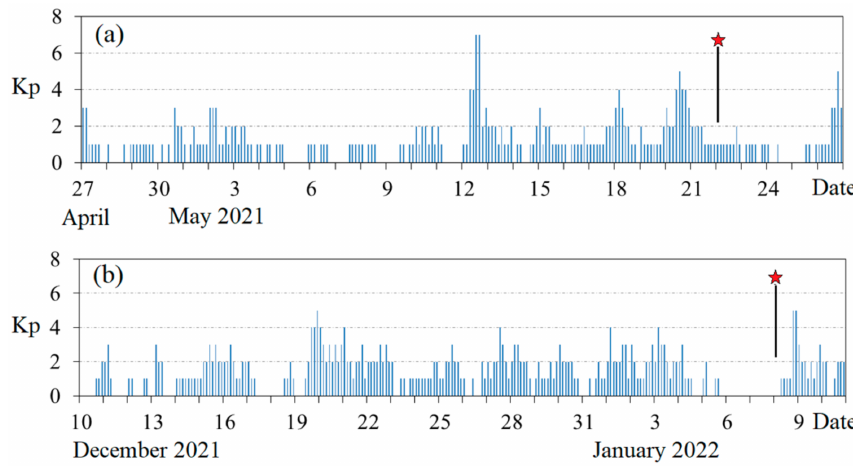
Figure 6. Variations in the Kp index ( a ) from 27 April to 26 May 2021 and ( b ) from 10 December 2021 to 10 January 2022. The red star stands for the earthquake occurring